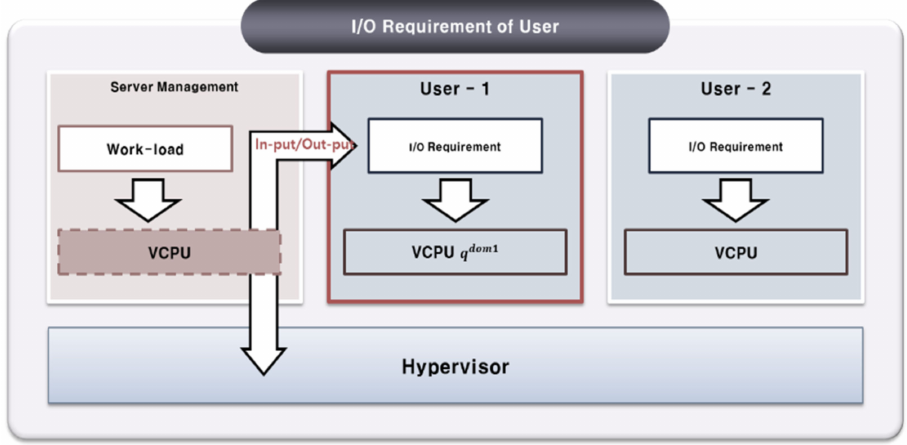
Figure 6. User required performance table: in case of heavy BIM S/W.